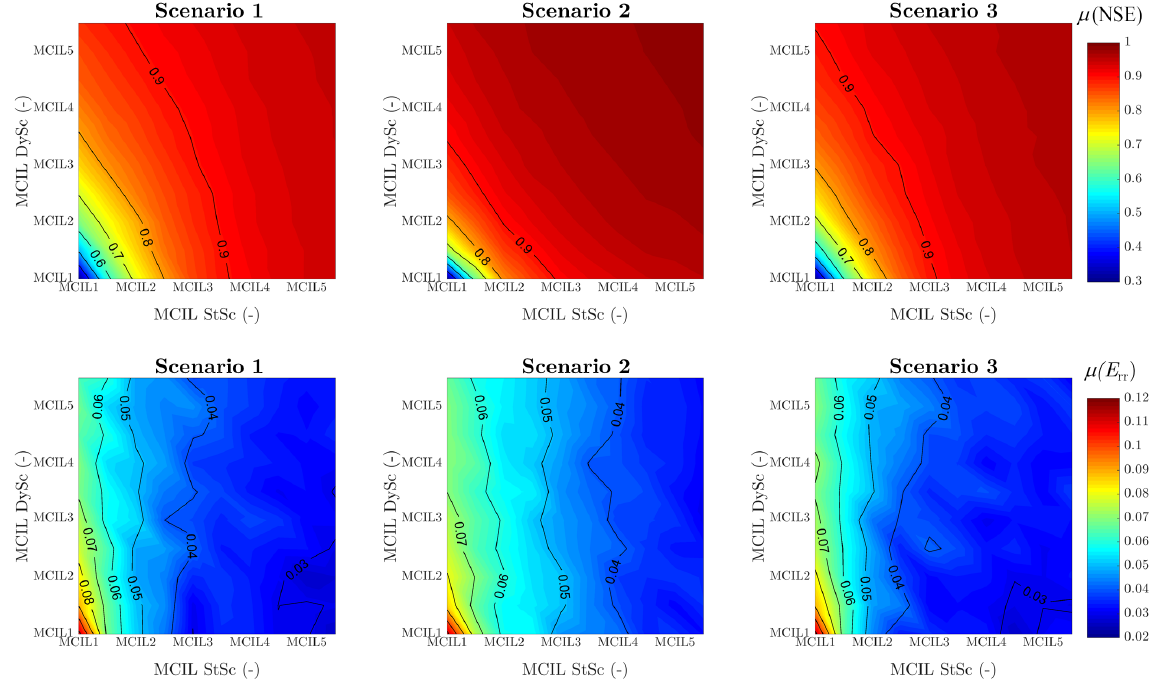
Figure 8. The µ ( NSE ) and µ (E rr ) values obtained in the case of different maximum citizen involvement level (MCIL) scenarios comparing involvement level from StSc and DySc sensors.